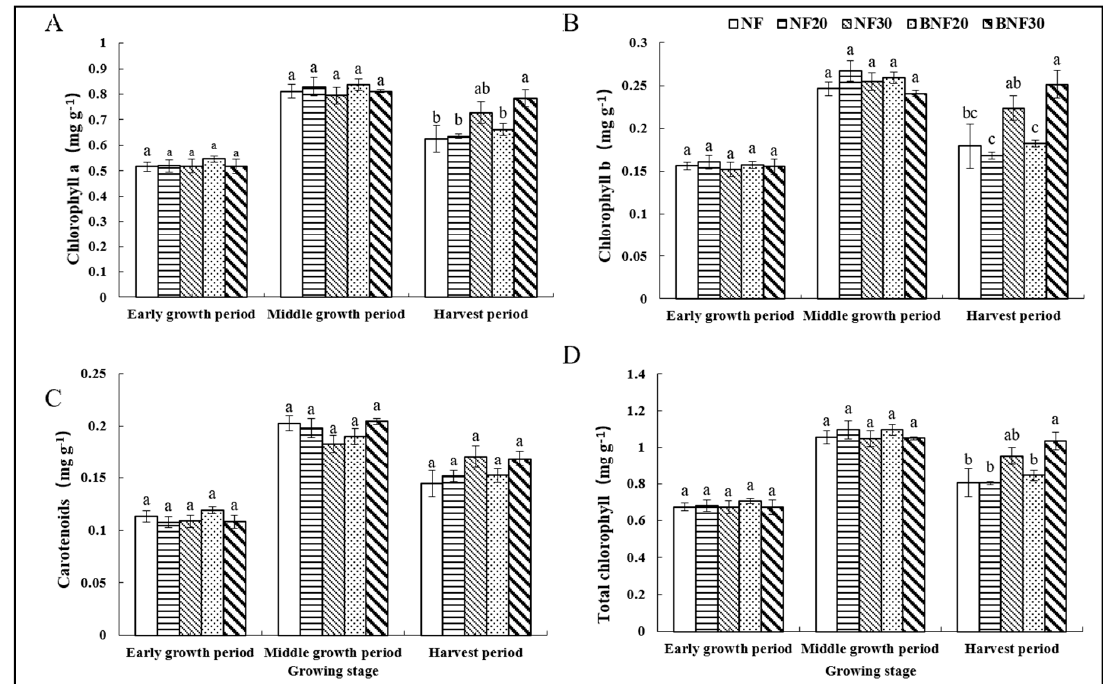
Figure 2. Effects of different fertilization treatments on leaf photosynthetic pigment content of ‘yellow rose’ cabbage at different growth stages: ( A ) chlorophyll a content; ( B ) chlorophyll b content; ( C ) carotenoids content; and ( D ) total chlorophyll content.